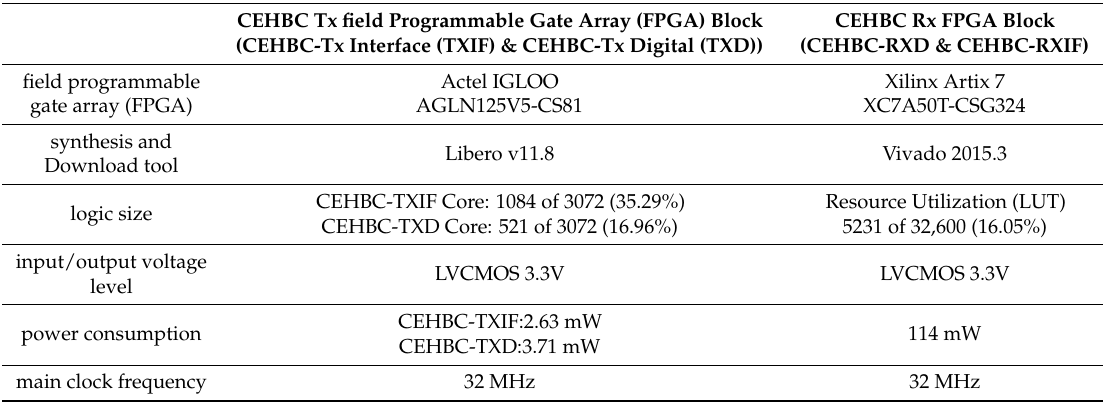
Table 3. Synthesis results of CEHBC digital blocks.